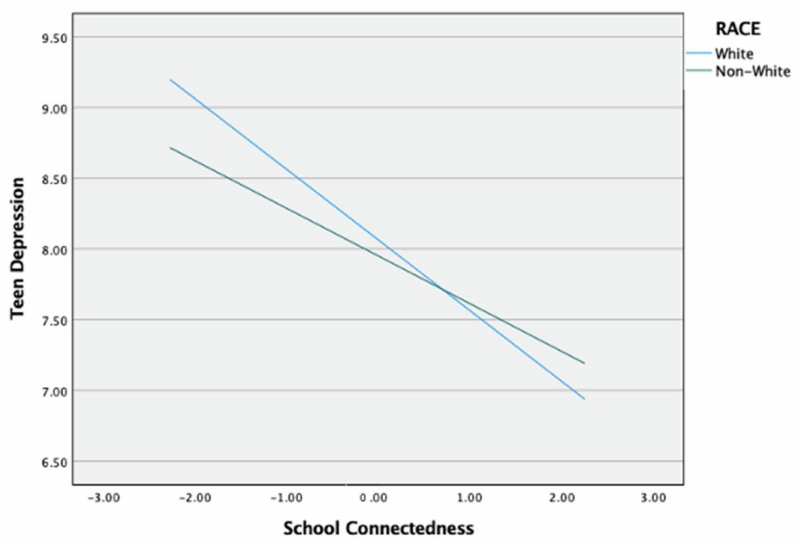
Figure 5. Moderation effect of race in the relationship between peer victimization and teen